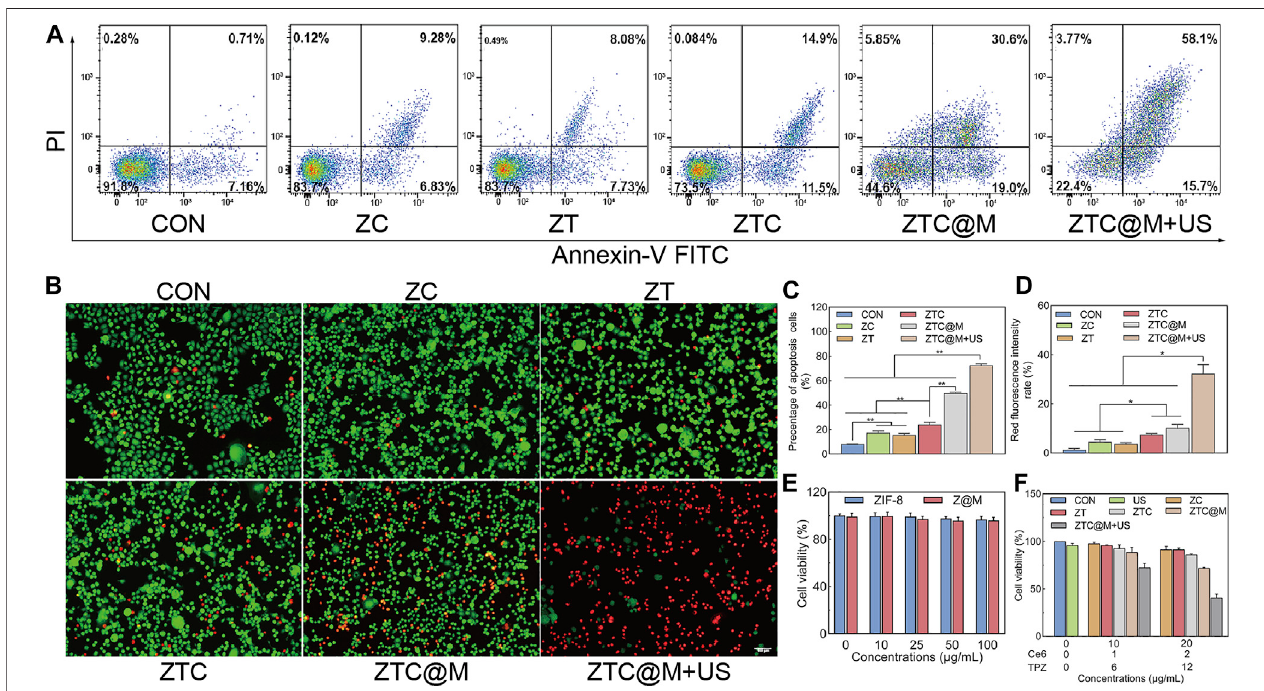
FIGURE6| Invitro therapeuticeffect.Calcein-AMandPIstaining fl uorescenceimagesofAGScellsafter varioustreatments (A) (100×).Flowcytometryanalysisfor apoptosisofAGScellsaftervarioustreatments (B) .Quanti fi cationofintracellular fl uorescenceintensityin A(C) .Thebarchartindicatesthepercentage ofapoptosiscells in B (D) . Cell viabilities of AGS cells treated with various probes at different concentrations in (E) and (F) . * p < 0.05, ** p < 0.0001.